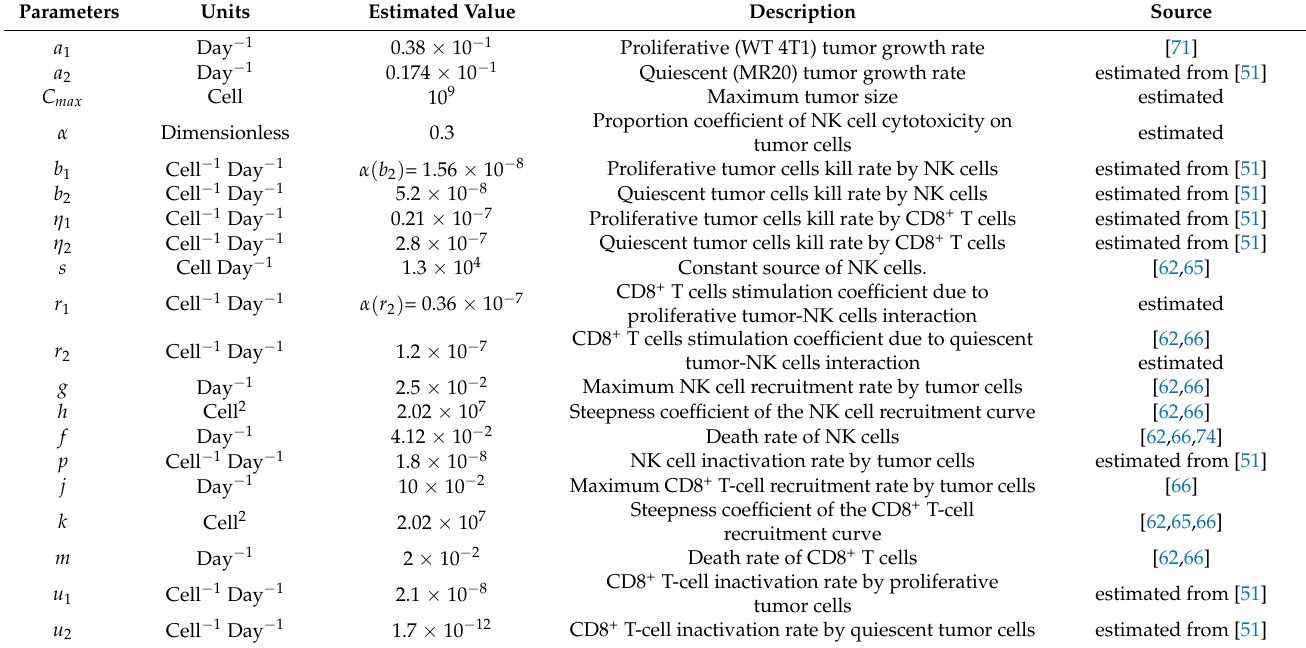
Table 1. Estimated Parameter